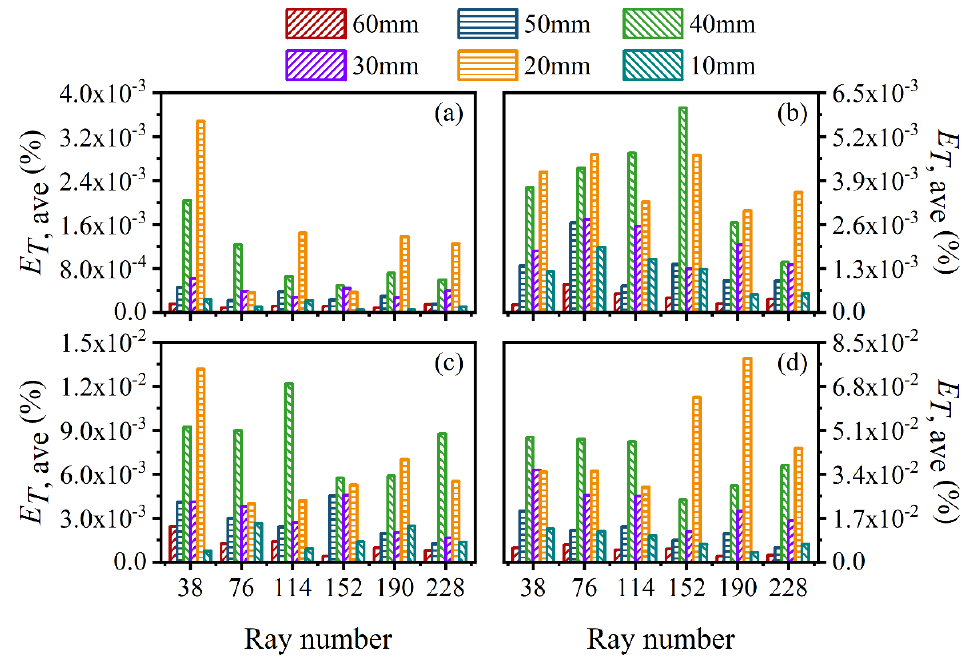
Figure 13. The average relative reconstruction error for the flame temperature at the main cross- sections in sooting regions. ( a ) SNR = 80 dB; ( b ) SNR = 65 dB; ( c ) SNR = 60 dB; ( d ) SNR = 46 dB.